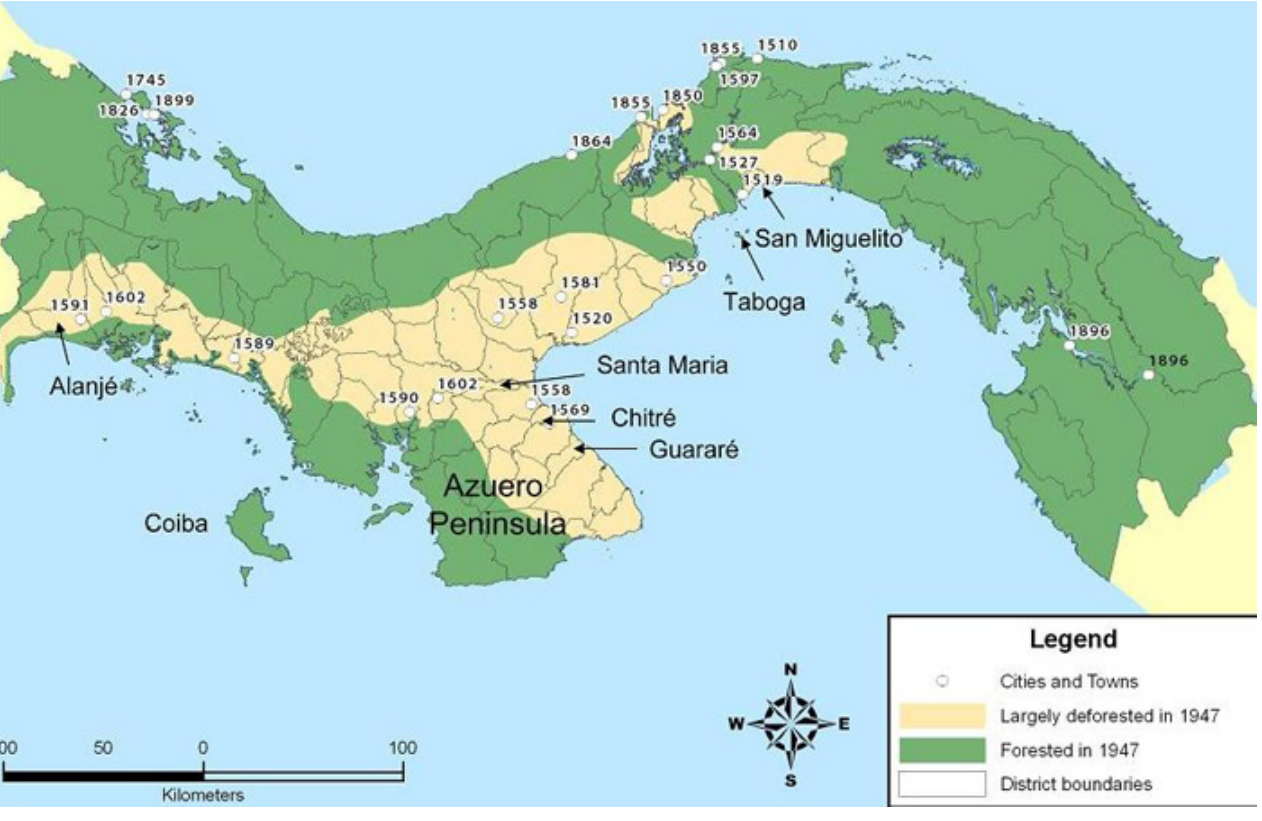
Fig. 1. Map of the Republic of Panama showing district boundaries, areas forested in 1947, areas largely deforested in 1947, foundation dates of the first towns that have since been occupied continuously, and place names mentioned in the text. Spaniards settled the dry Pacific arc (most of the pale yellow area) in the 16th century. The remainder of the country was settled in the 19th and 20th centuries or remains in old-growth